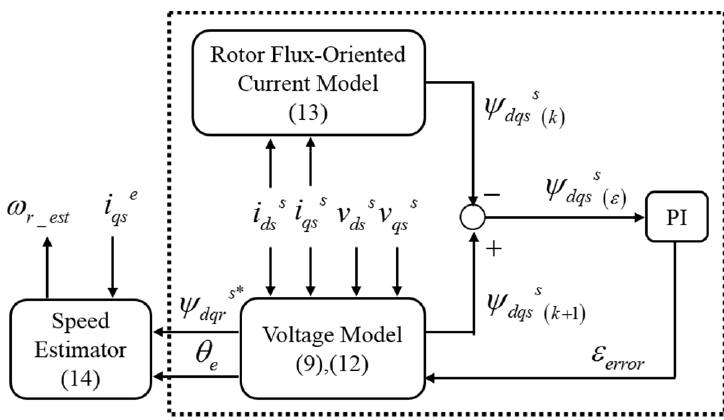
Figure 4. Block diagram of flux and speed estimator.